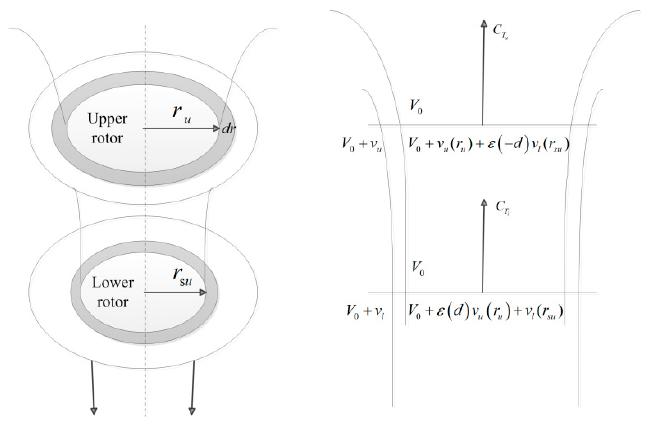
Figure 3. Interaction model in axial flight.